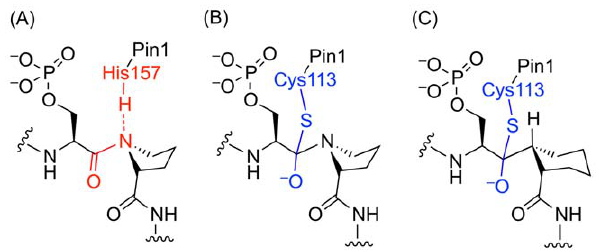
Figure 1. Ketone inhibitors were designed to mimic the tetrahedral intermediate of proposed mechanism B. (A) Proposed Pin1 hydrogen-bond assisted twisted amide mechanism [25], (B) Pin1 Cys113 nucleophilic-addition mechanism tetrahedral intermediate proposed by Ranganathan et al [26]. (C) Electrophilic ketone inhibitor designed to mimic the proposed tetrahedral interme- diate upon Cys113-S nucleophilic addition.